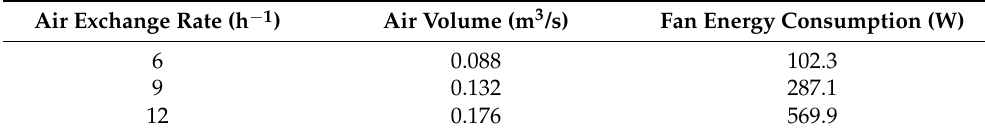
Table 2. Energy consumption under different working conditions.